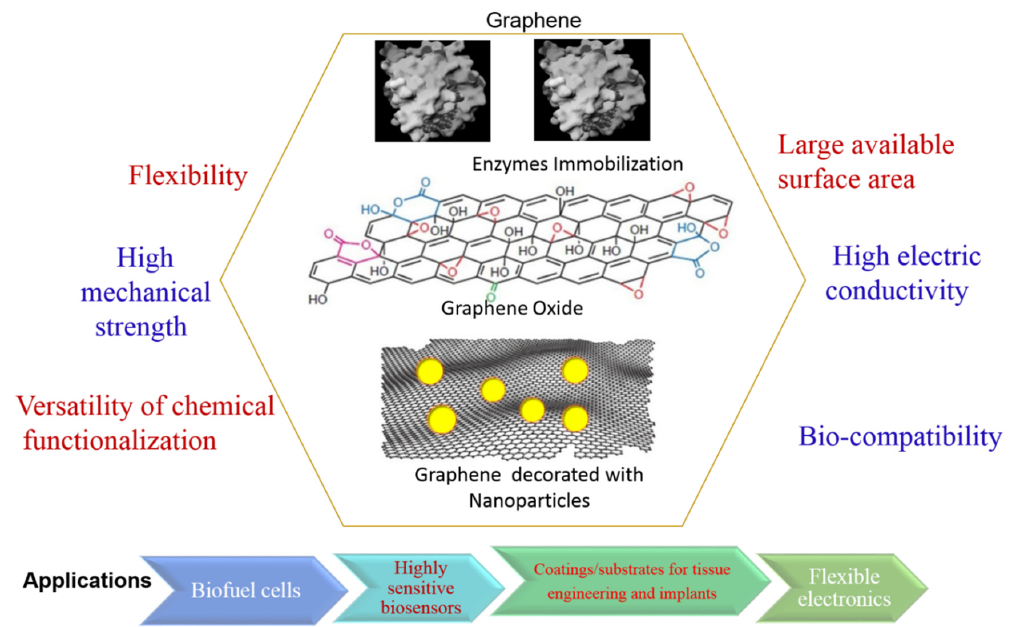
Figure 4. Enzyme immobilization on graphene- diversity in applications.